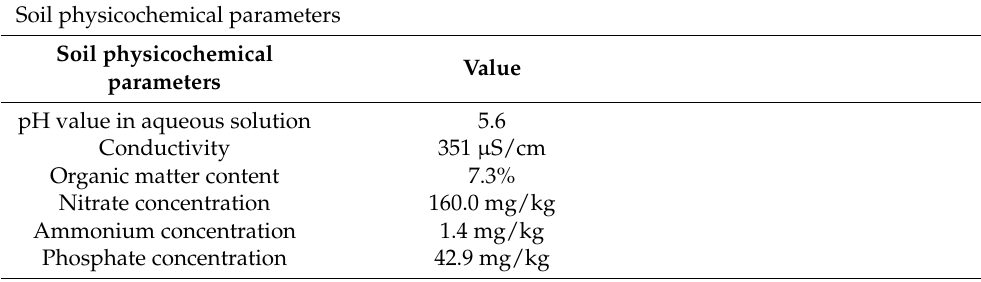
Table 1. Soil Physicochemical parameters and concentration of elements in